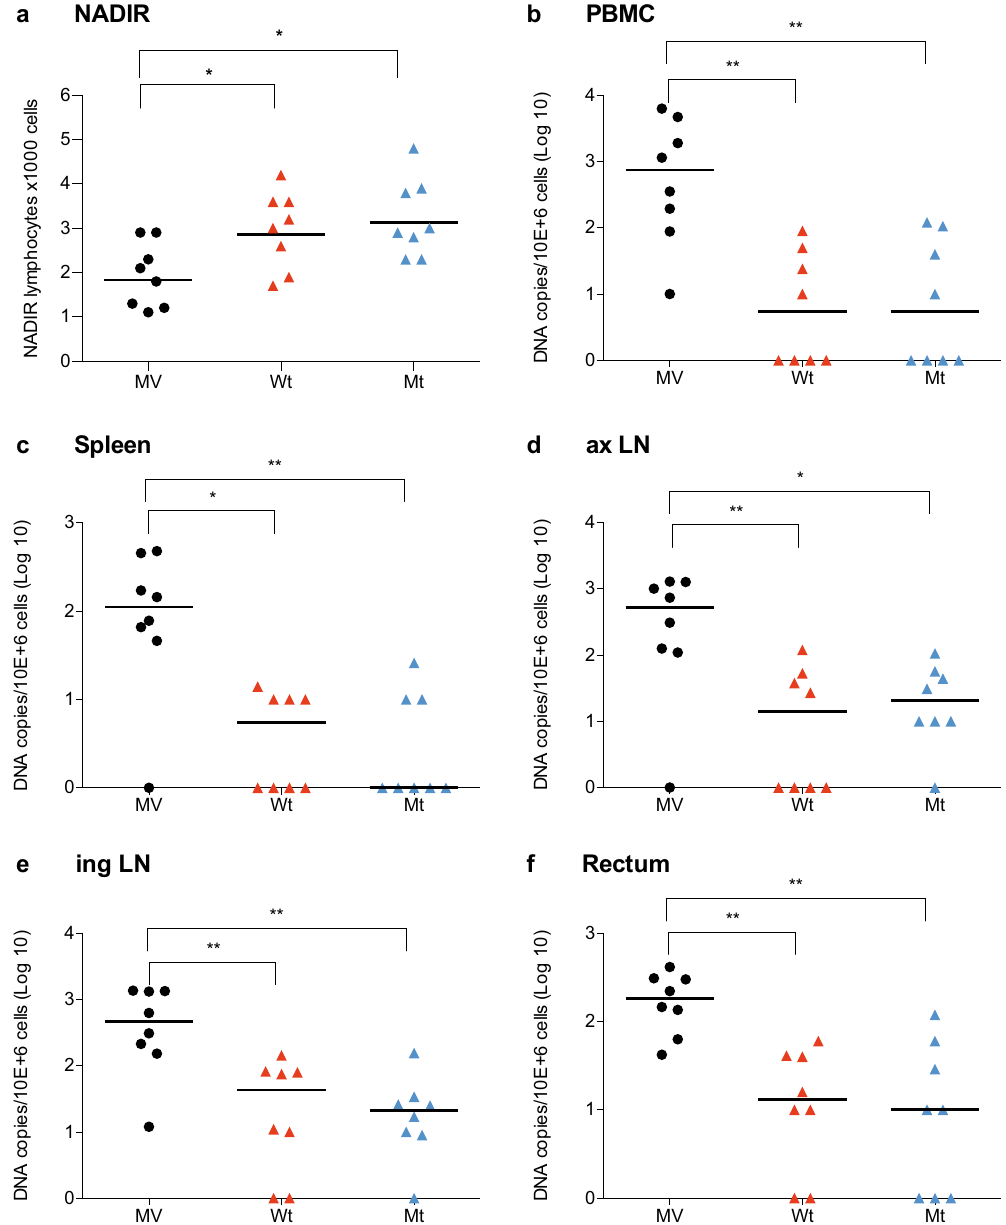
Fig. 3 MV-SHIV vaccine protects from lymphocyte depletion and limits DNA proviral reservoir seeding. a Blood lymphocyte NADIR after challenge (group Geomeans are plotted as a horizontal line; P values are calculated by Kruskal – Wallis and Dunn ’ s multiple comparisons tests). b – f At necropsy (week 13 or > ) SHIV DNA copies per 10 6 cells in PBMC ( b ), spleen ( c ), axillary ( d ), and inguinal ( e ) lymph nodes, and rectum ( f ). MV: unmodi fi ed MV vector, Wt: MV-SHIV Wt, Mt: MV-SHIV IS domain mutants. Group medians are plotted as a horizontal line; P values are calculated by Kruskal – Wallis and Dunn ’ s multiple comparisons tests. P values: NS > 0.05, *< 0.05, **<